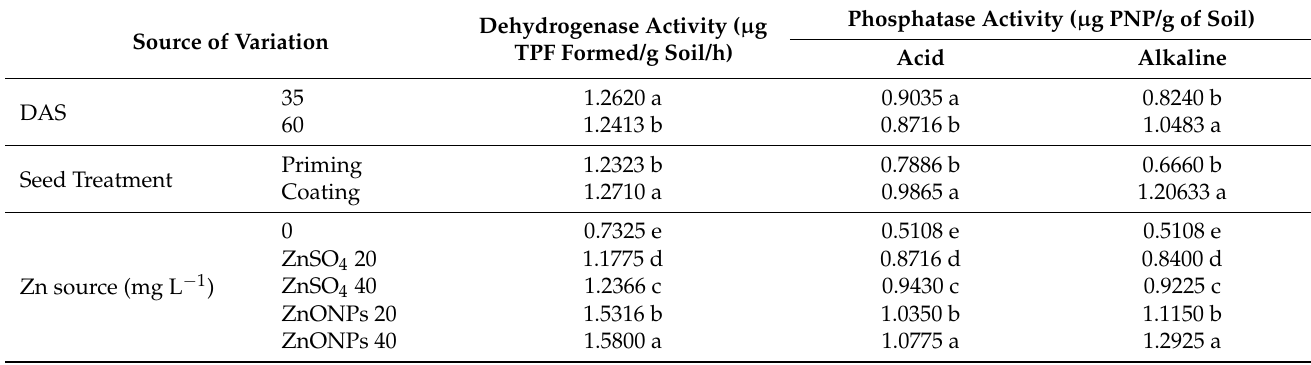
Table 7. Effect of time duration (DAS), seed treatment with various concentrations of ZnONPs on soil enzyme activities in fodder maize crop (variety J-1006) grown under field conditions.